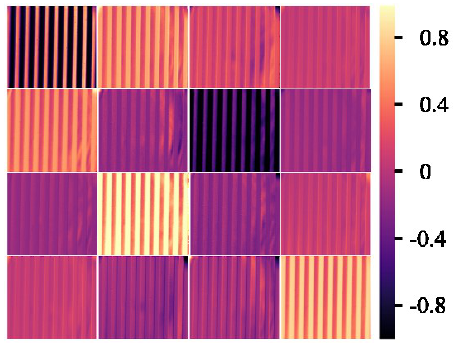
Fig. 2. First preliminary Mueller matrix image of 11 µm wide lines. Each image contains the pixelwise values of one element of the 4x4 Mueller